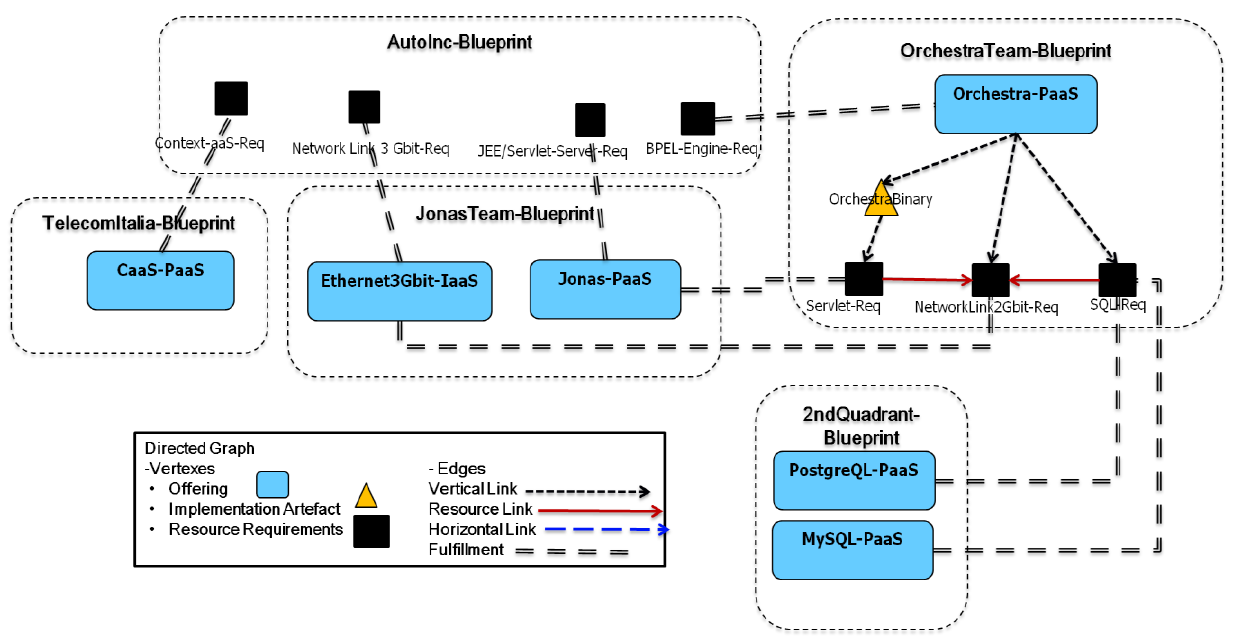
Figure 8. Resolving the sample Target Blueprint AutoInc-Blueprint